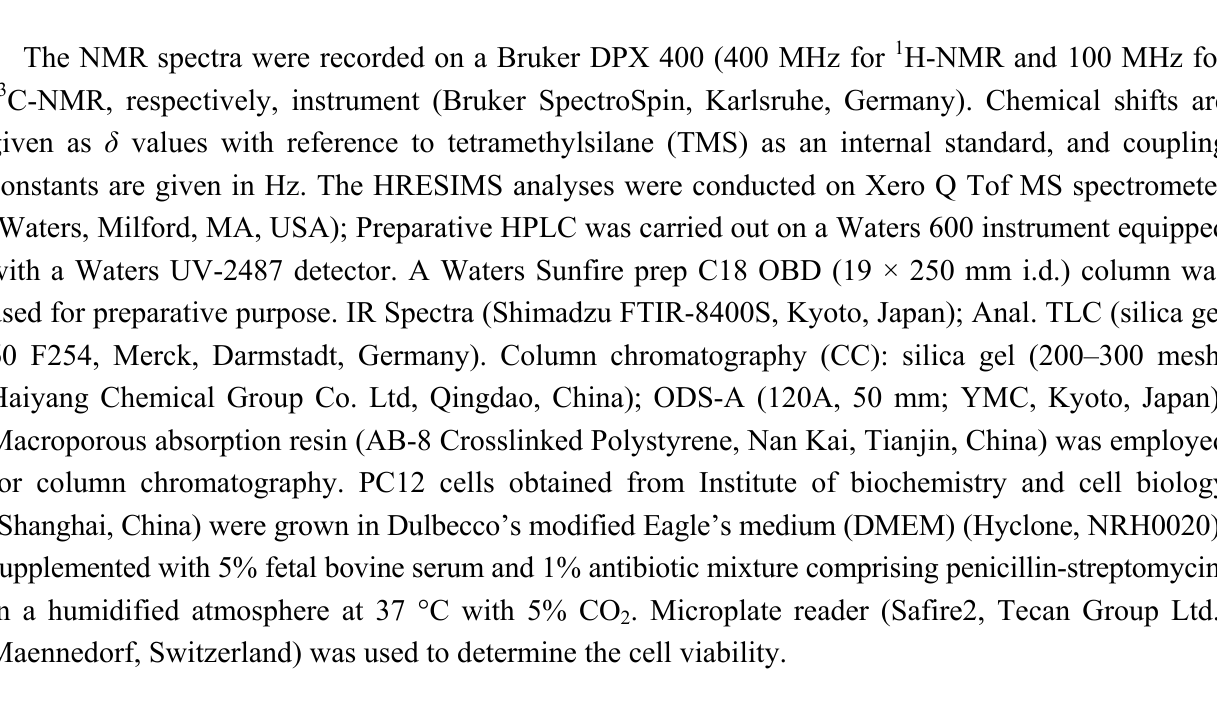
Effects of the tested compounds on A β -induced PC12 cell death. Cell viability was measured by MTT assay. Results are expressed as mean ± SD (n = 8) of three independent experiments. The 100% value was